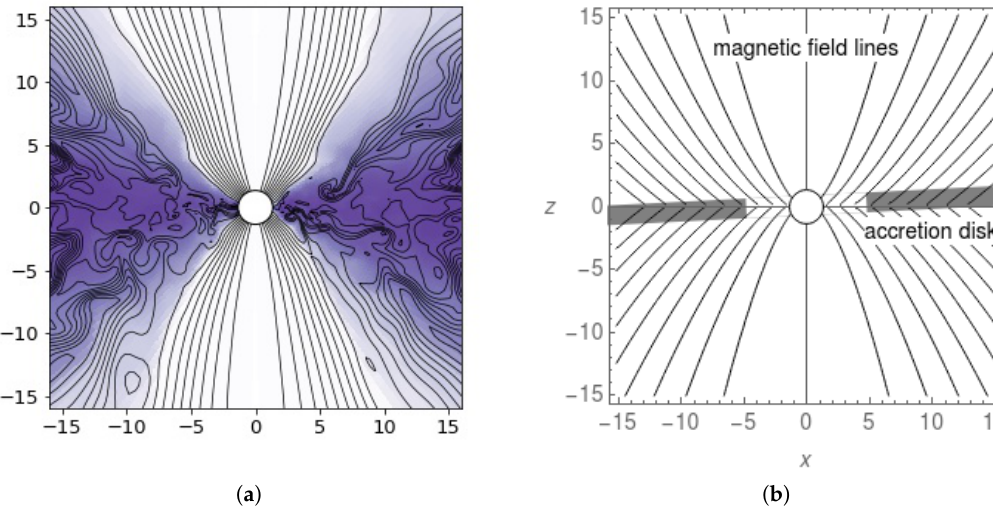
Figure 1. ( a ) Magnetic field lines outside a toroidal accretion structure around BH–result of General Relativistic Magnetohydrodynamics simulation in HARM software [17,18]. ( b ) Schematic picture of a Kerr BH immersed in a parabolic magnetic field and an orbiting Keplerian disk inclined to the field